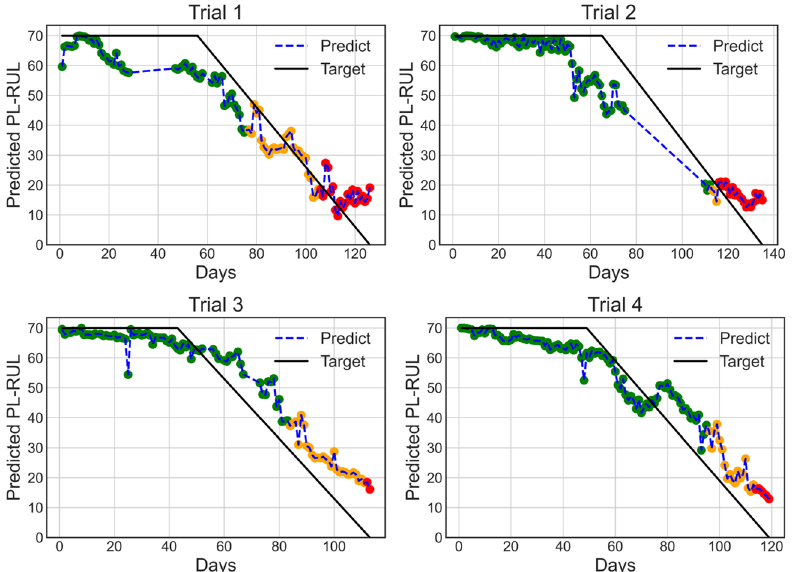
70 T days for trials 1 to 4 using A/C dataset, us- Figure 6. 4-Fold cross-validation results with = RUL ing Extremely randomized trees optimal Linearity setting (n_estimators = 100, max_depth = None, min_samples_leaf = 2, min_samples_split = 10).